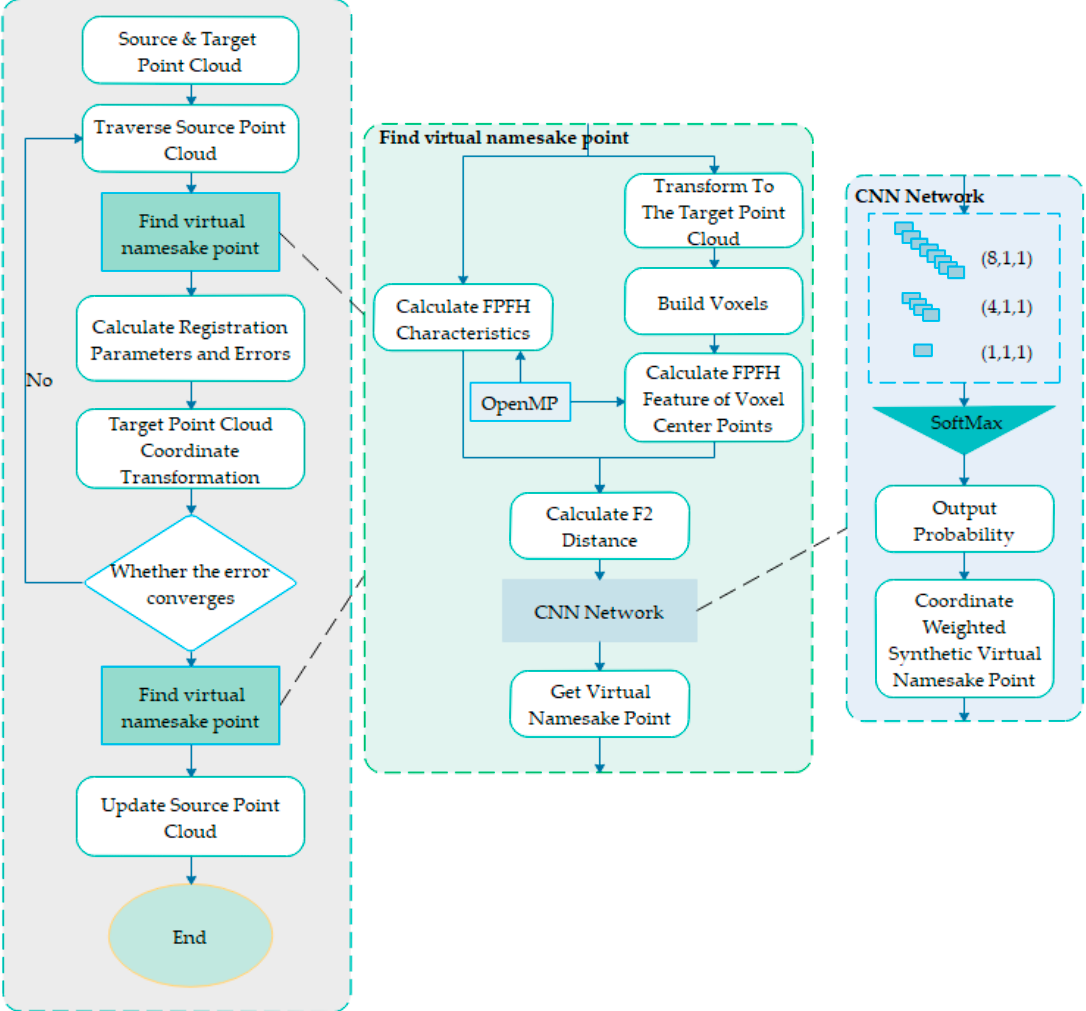
Figure 1. Flow chart of virtual namesake point multi-source point cloud data fusion based on FPFH feature difference.